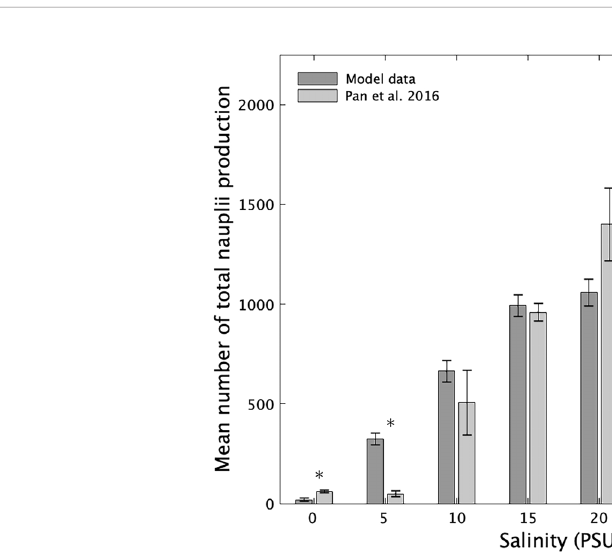
FIGURE 4 | Comparison of experimental (in grey) and simulation (dark grey) results of the total number of nauplii produced by 8 females of A. royi at eight salinities. Vertical bars represent the mean values over four replicates and the error bars represent the standard error. Asterisks indicate a signi fi cant difference between experimental and simulation